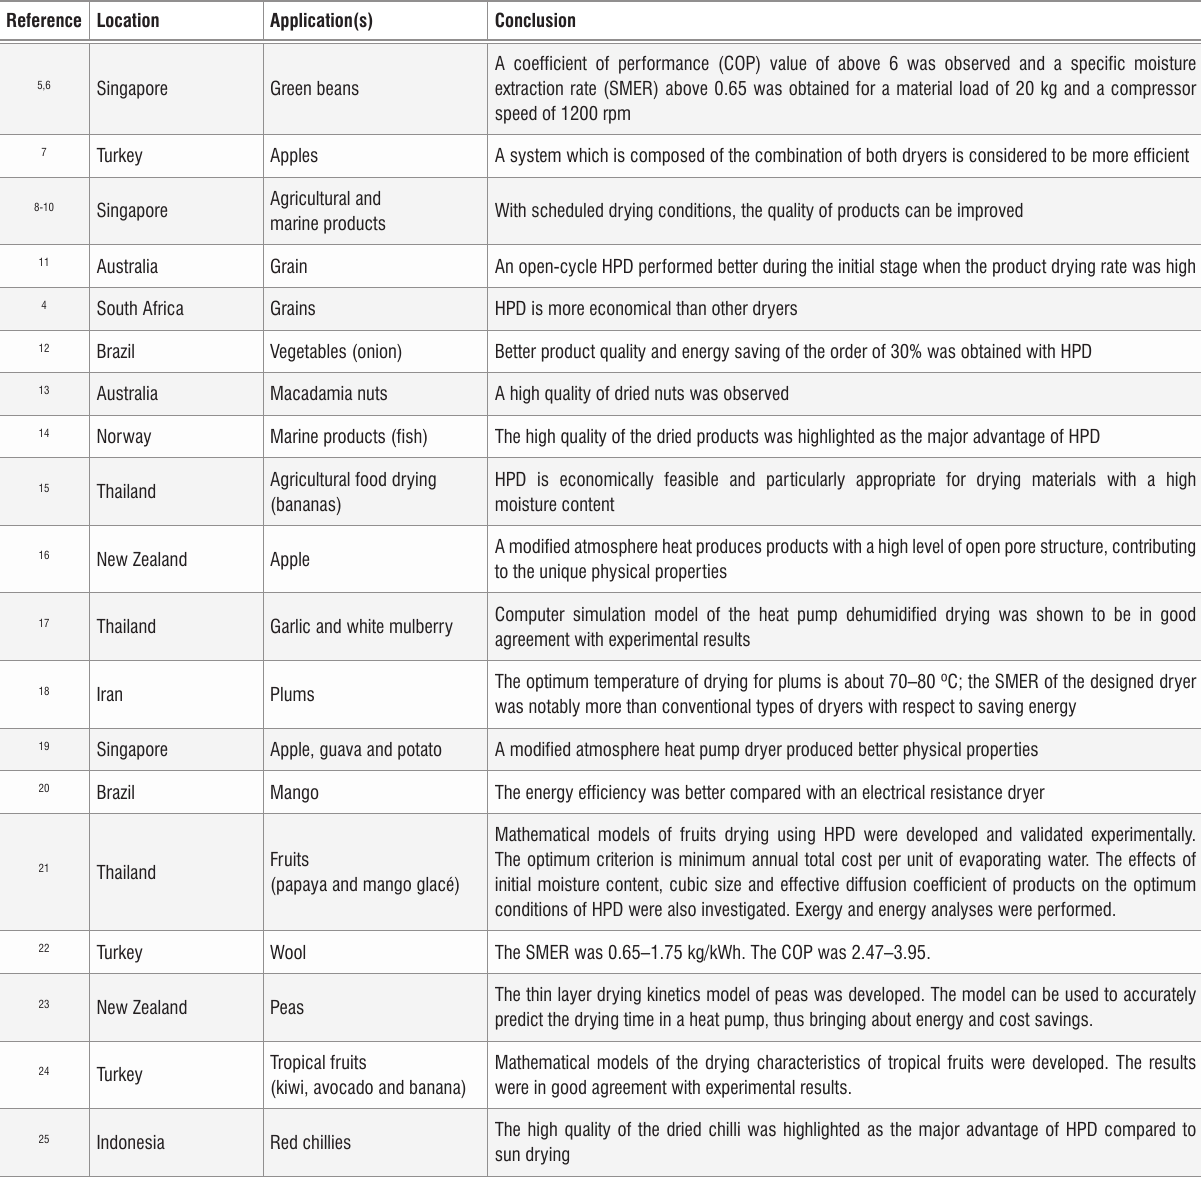
Table 1: Summary of studies on heat pump drying (HPD) Reference